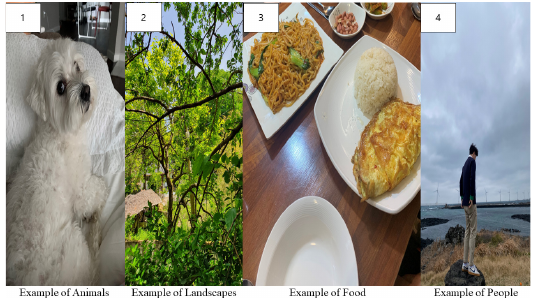
Figure 6. Example of pictures.